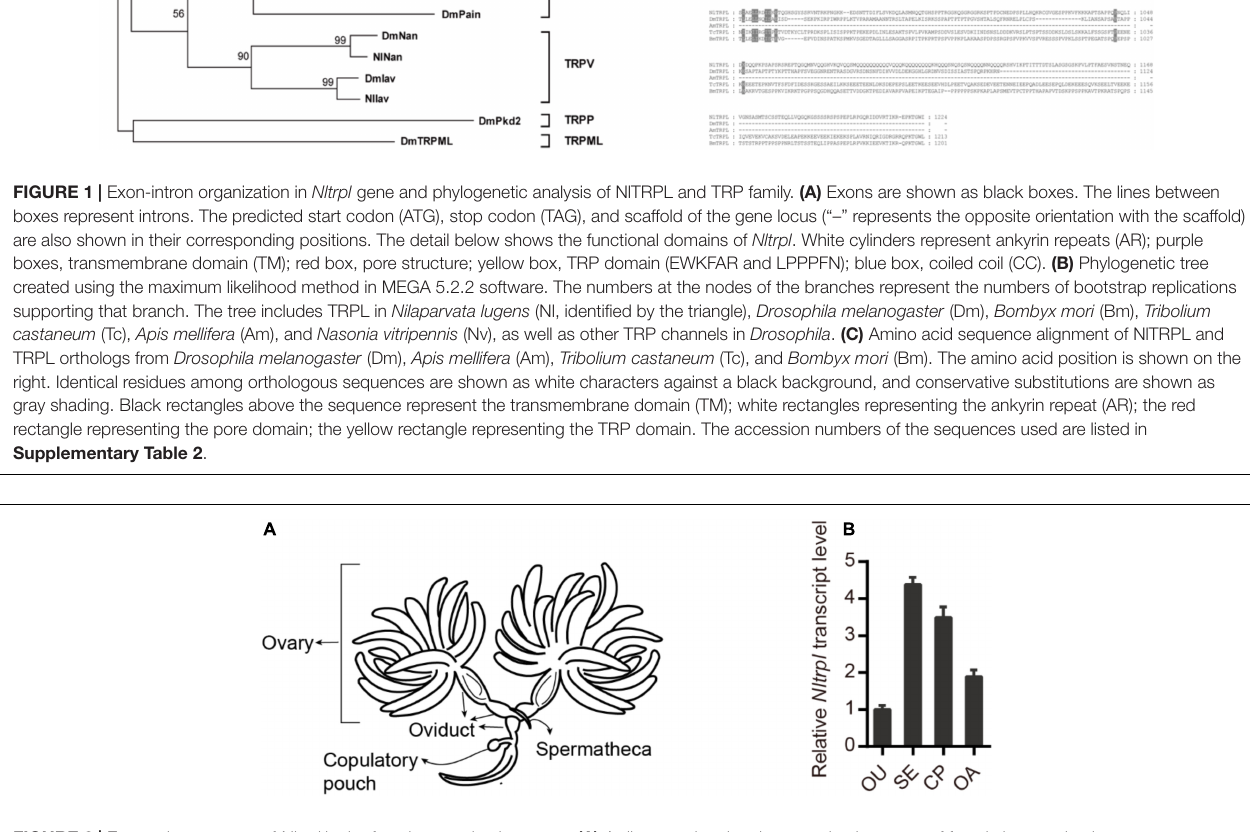
FIGURE 2 | Expression patterns of Nltrpl in the female reproductive organ. (A) A diagram showing the reproductive organ of female brown planthoppers. (B) Expression patterns of Nltrpl in the four female reproductive organ regions: oviduct (OU), spermatheca (SE), copulatory pouch (CP), and ovary (OA). Data are expressed as mean ±